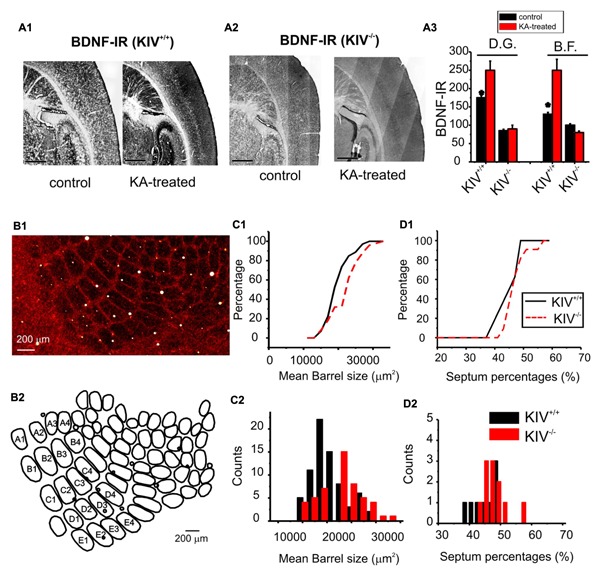
Intact barrel structure with reduced activity-driven expression of BDNF in KIV –/– mice. (A) Photograph of BDNF-IR in thalamocortical sections of kainic acid treated (right) vs. control (left) wild-type (A1) and mutant (KIV-/-, A2) mice. (A3) the intensity of BDNF-IR was measured along lines across the barrel field (BF) and hippocampus dentate gyrus area (DG), respectively. n = 4 mice in each group. Scale bars: 1 mm. (B) Photograph of cytochrome-C stained BF in a flattened tangential section across layer IV of somatosensory cortex of wild-type mice (B1). The BF was re-constructed using Neurolucida®, from which the morphometric data of BF was analyzed (B2). (C) The size of individual barrels within the primary mystacial BF (PMBF A1 though E4) was significantly larger in the mutant, N=4 in each group (C). (D) In contrast, the septum percentage within PMBF did not show significant differences. The measurements were made from 6 pairs of littermate control (n= 6) and mutant (n= 6) mice, respectively.